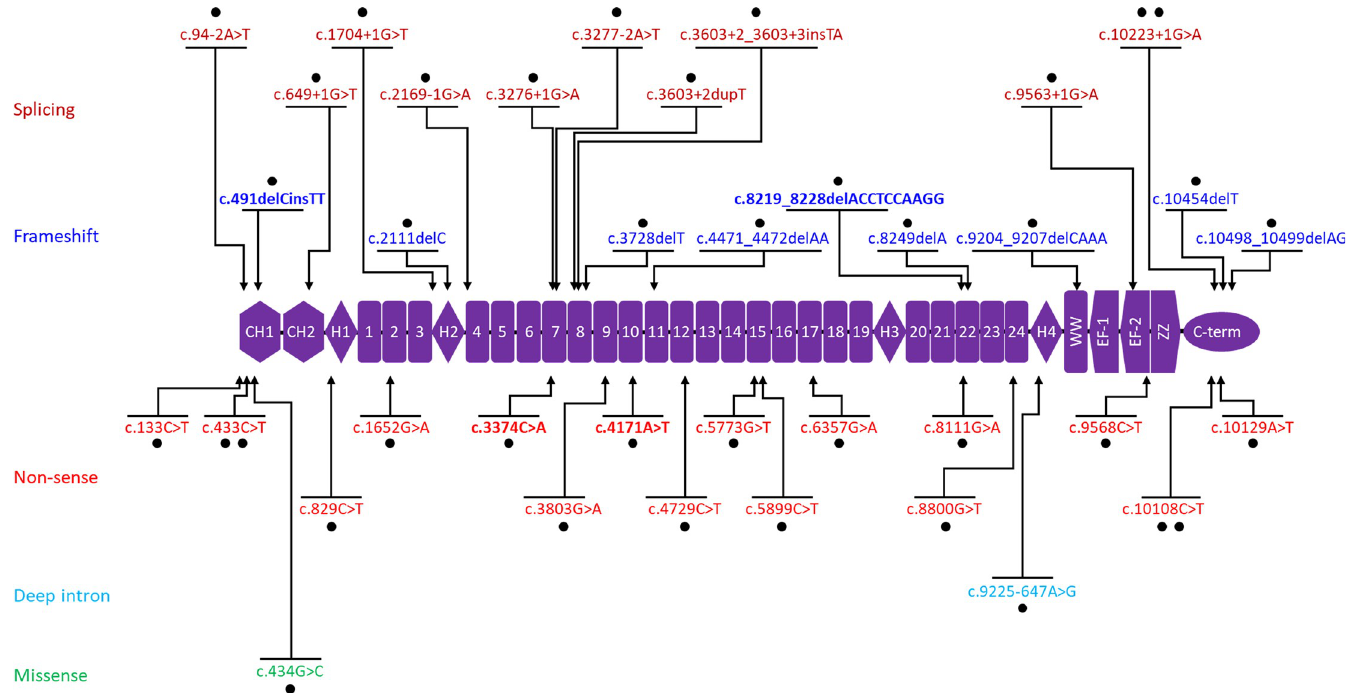
Fig 4. Small sequence variants in DMD in 40 probands with dystrophinopathy. Red, blue, pink, light blue, and green colors indicate splicing, frameshift, non-sense, deep intron, and missense variants, respectively. Bold text indicates novel variants. Dots indicate the frequency of each